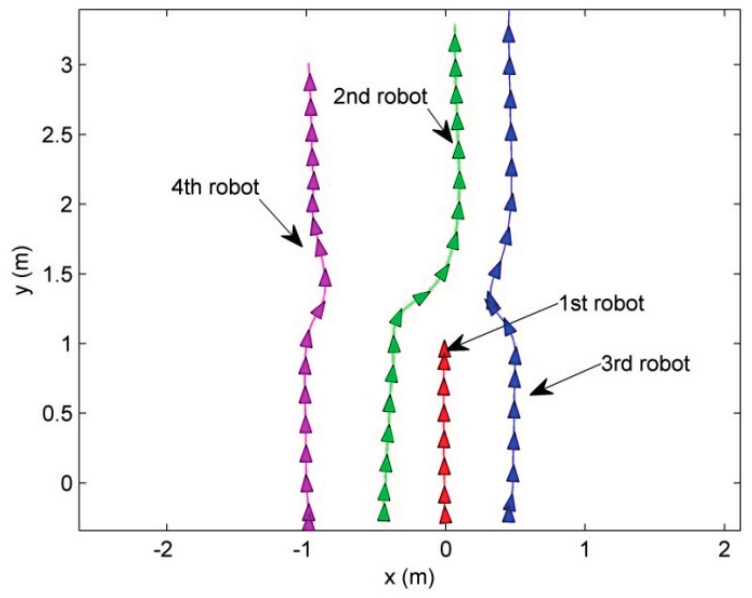
Figure 14. The routes of the robots in the situation of the fault of the leader.